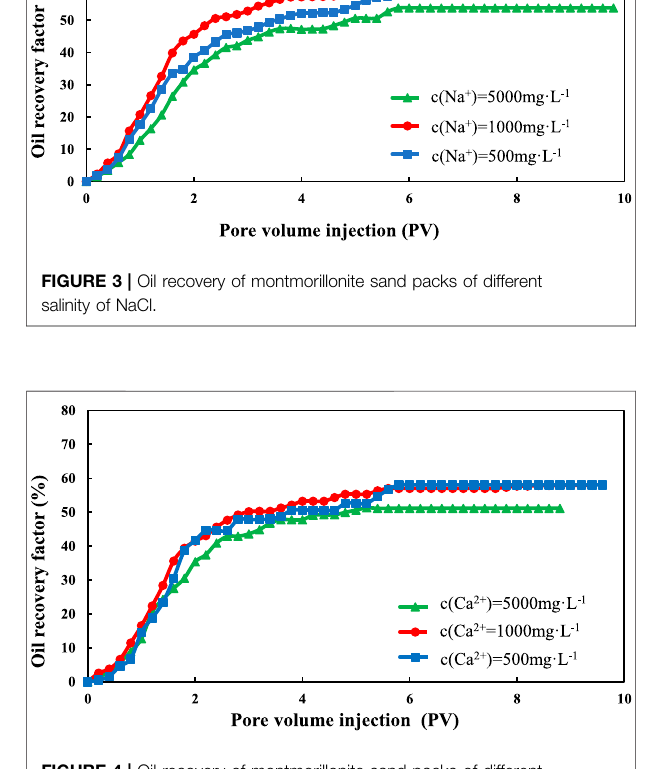
FIGURE 4 | Oil recovery of montmorillonite sand packs of different salinity of CaCl 2 .